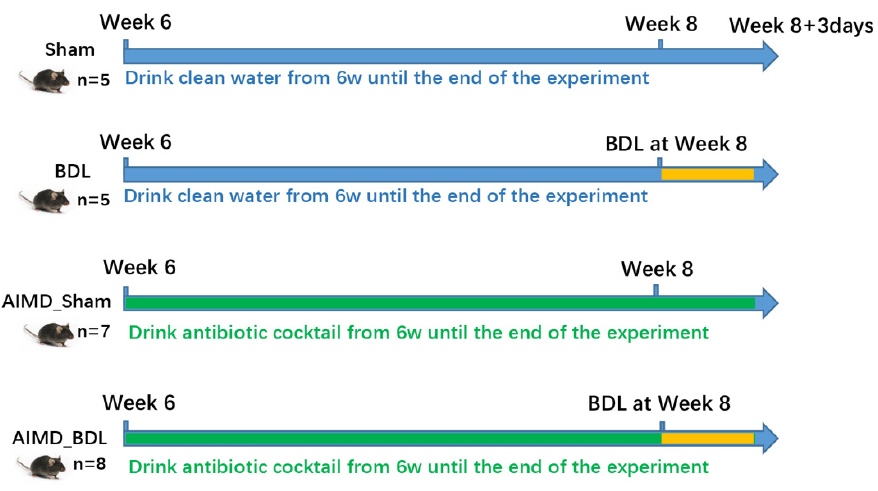
Figure 1. Experimental flowchart. The C57BL/6J male mice were divided into four groups (Sham group, AIMD_Sham group, BDL group, and AIMD_BDL group) using a random assignment table. The mixed antibiotics were added to the drinking water of AIMD_Sham and AIMD_BDL groups at week 6. All groups completed the corresponding Sham surgery or BDL surgery at week 8. Three days after completion of the sham ligation and bile duct ligation procedures, all groups of mice were weighed and euthanized. Table 1. Serum markers of liver injury in each group after AIMD and BDL surgery.